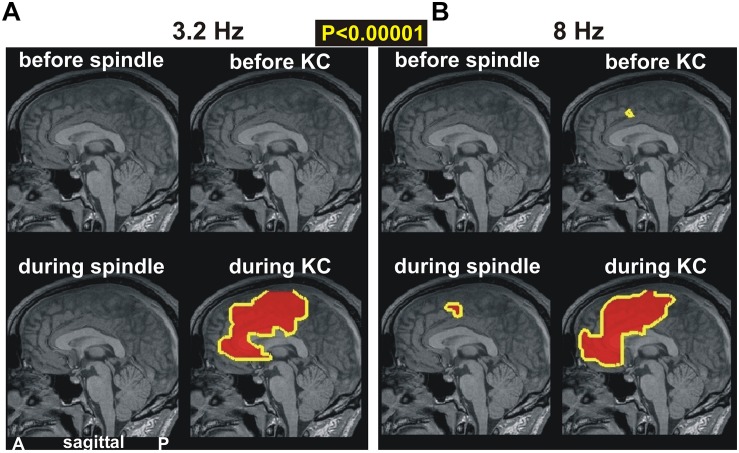
The key prominent changes in spectral power in midline areas for spindles and KCs at frequencies of (A) 3.2 Hz and (B) 8 Hz, respectively. Top rows show changes before periods while bottom rows for during periods. Left column of each figurine is for spindles while right column for KCs. A prominent broad increase is seen only during KCs in both frequency bands (bottom rows). The top row shows again the only prominent increase in the dcACC1 before KCs. A nearby prominent increase is seen during spindles and a much wider area during KCs.